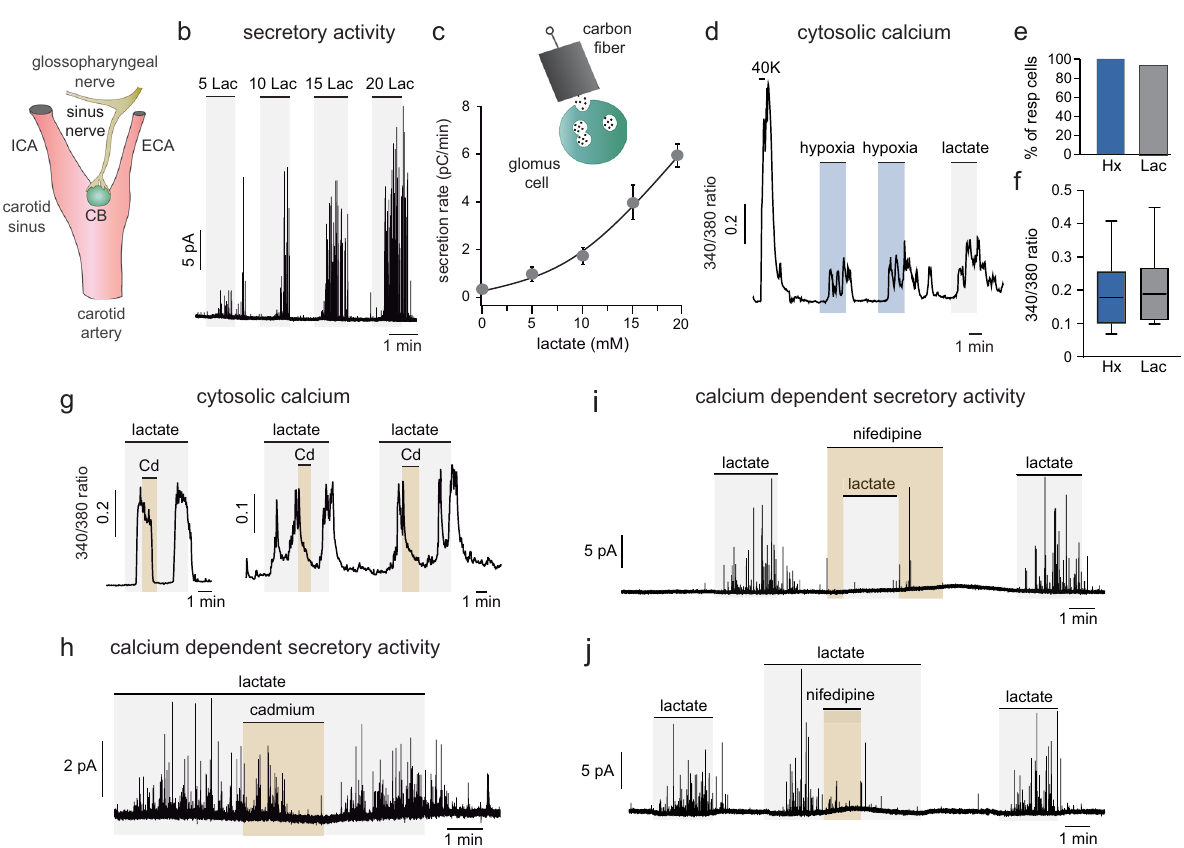
Fig. 2 Activation of carotid body cells by lactate. a Scheme of the carotid bifurcation representing the location of the carotid body (CB) and sensory innervation (ICA and ECA, internal and external carotid artery). b , c Secretory activity (catecholamine release measured with a polarized carbon fi ber) induced by extracellular lactate in glomus cells in CB slices. Average values (mean ± SEM) in ( c ) are from: 5 Lac ( n = 5 cells/5 mice); 10 Lac ( n = 8 cells/8 mice); 15 Lac (6 cells/6 mice); 20 Lac ( n = 5 cells/5 mice). d Increase in cytosolic Ca 2 + induced by K + (40 mM), hypoxia (O 2 tension ≈ 15 mm Hg, blue), and lactate (5 mM, gray) in dispersed single glomus cells. e Percentage of cells recorded that responded to hypoxia (blue) and lactate (5 – 10 mM; gray) ( n = 20 cells from 6 mice). f Box plots summarizing the amplitude of the responses to hypoxia and lactate ( n = 20 cells from 6 mice). Mean± SEM values are: hypoxia: 0.19 ± 0.02; 5 mM lactate: 0.21 ± 0.02. In the boxplots the middle line is the median, the lower and upper hinges (IQR, interquartile range) correspond to the fi rst and third quartiles, the upper whisker extends from the hinge to the largest value no further than 1.5 × IQR and the lower whisker extends from the hinge to the smallest value at most 1.5 × IQR. g Representative recordings ( n = 5) of lactate (5 mM)-induced rise in cytosolic Ca 2 + and its inhibition by Cd 2 + . h Representative amperometric recording illustrating the reversible inhibition of lactate (10 mM)-induced secretory activity by extracellular Cd 2 + . Similar recordings were obtained in three separate experiments. i , j Amperometric recordings of the inhibitory effects of nifedipine (0.5 µ M) on lactate (10 mM)-induced secretion applied before and after exposure to lactate (4 experiments in 3 mice). Source data are provided as a Source data fi